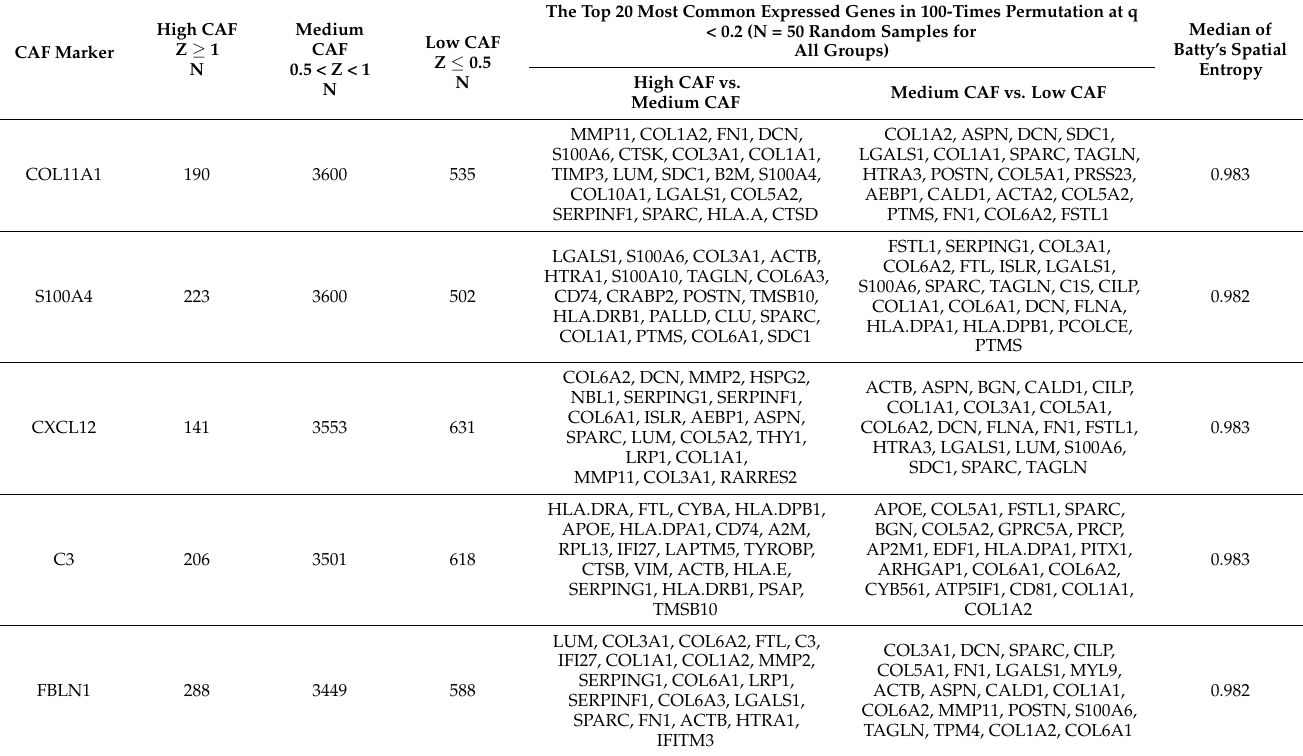
Table 1. Differentially expressed genes in five different CAF phenotypic contexts and their spatial